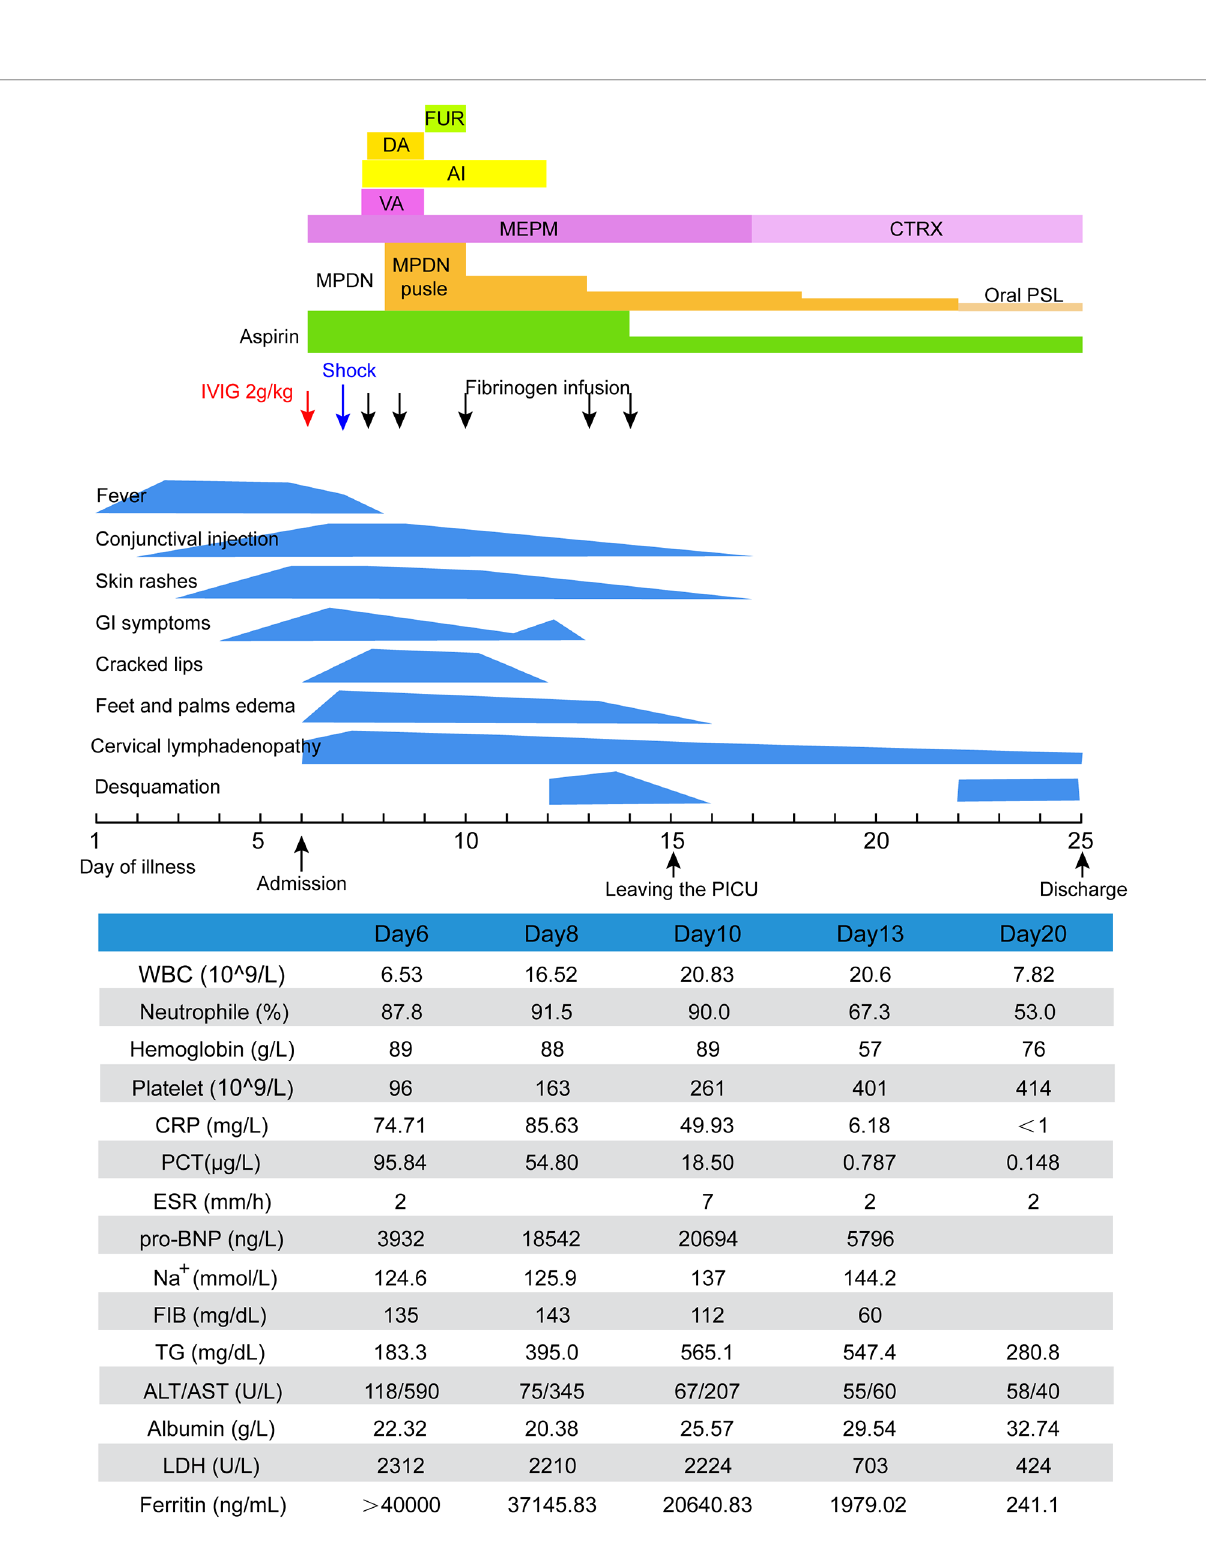
symptoms and laboratory test results gradually improved ( Figure 2 ). On day 21, he was transferred out of the PICU. Unexpectedly, he developed recurrent fever and abdominal pain